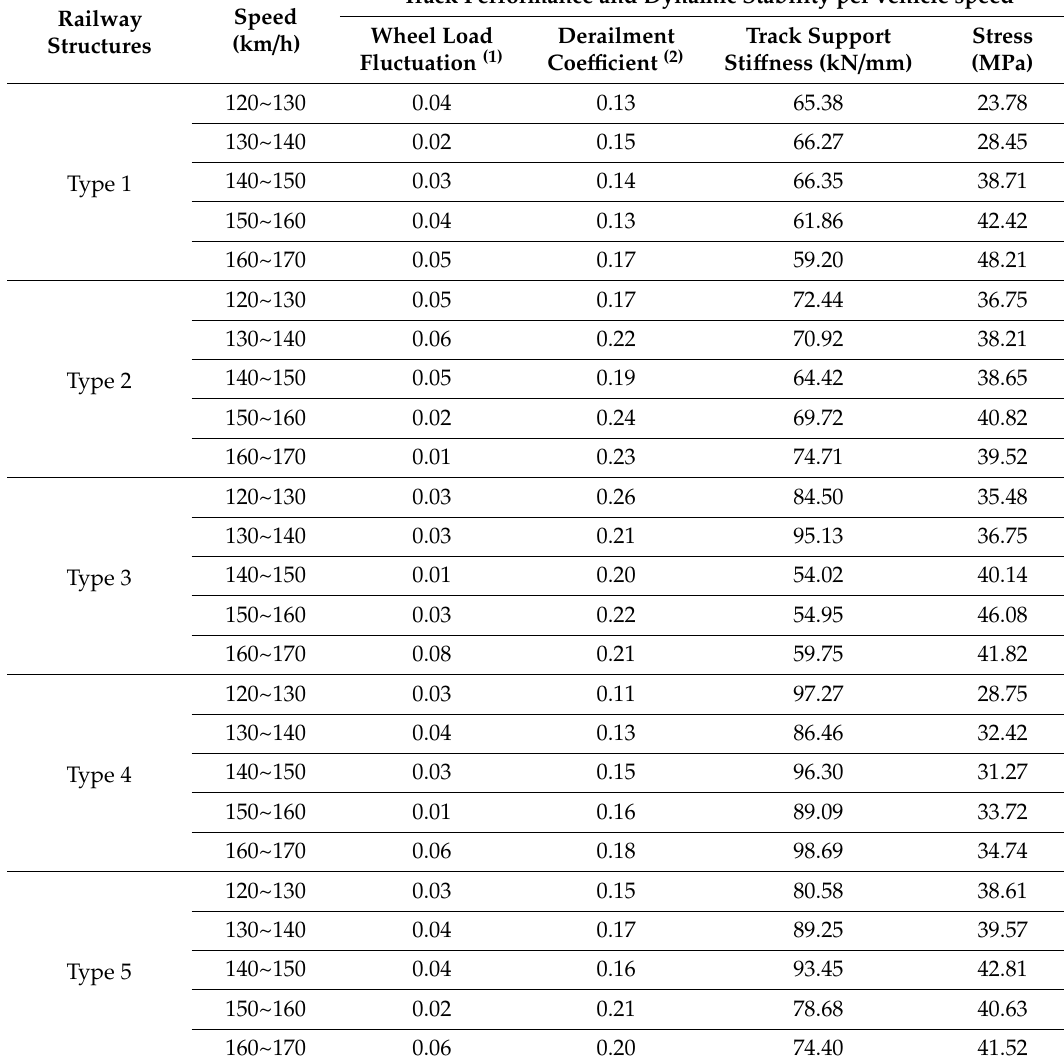
Table 10. Calculation result of track performance and dynamic Stability according to railway structures per vehicle speed ranges (concrete track types)